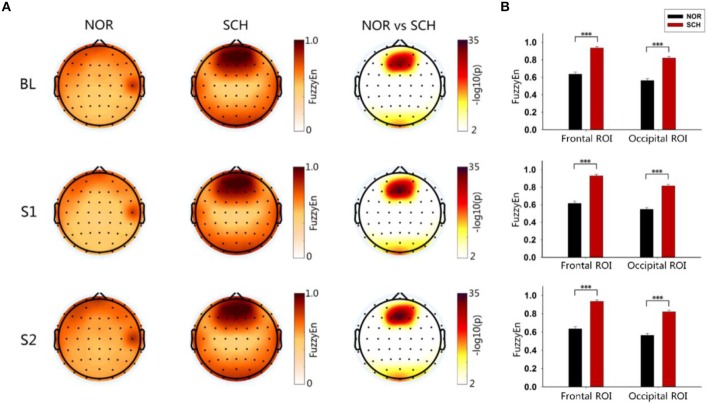
Brain topography and histogram of FuzzyEn values in three states. Panel (A) shows the topographic map of entropy in the three states of the two groups. The darker the color in the first two columns was, the greater the entropy would be. The third column took the logarithm of the p-value of the statistical test: the darker the color was, the greater the difference would be. Panel (B) represents the ROI histograms of the two most significant brain regions. Black represents normal controls, while red represents schizophrenia patients. ***Less than the significance p-value of 0.001.